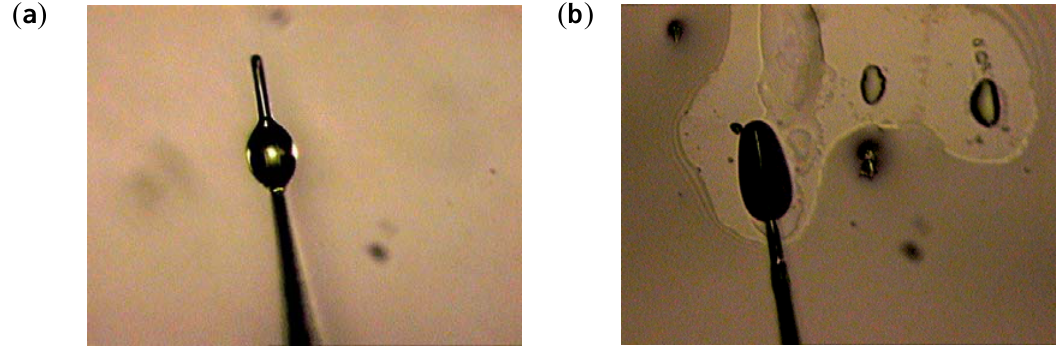
Figure 13. “Deformed” glycerin droplets were formed in desired locations by bringing a small probe (a) wetted in glycerin into close proximity to a sample. The probe was prepared from a tapered optical fiber, which has an epoxy microdroplet near its apex. Bringing the probe to a surface region covered with glycerin led to a glycerin microdroplet formation (b) under the probe.